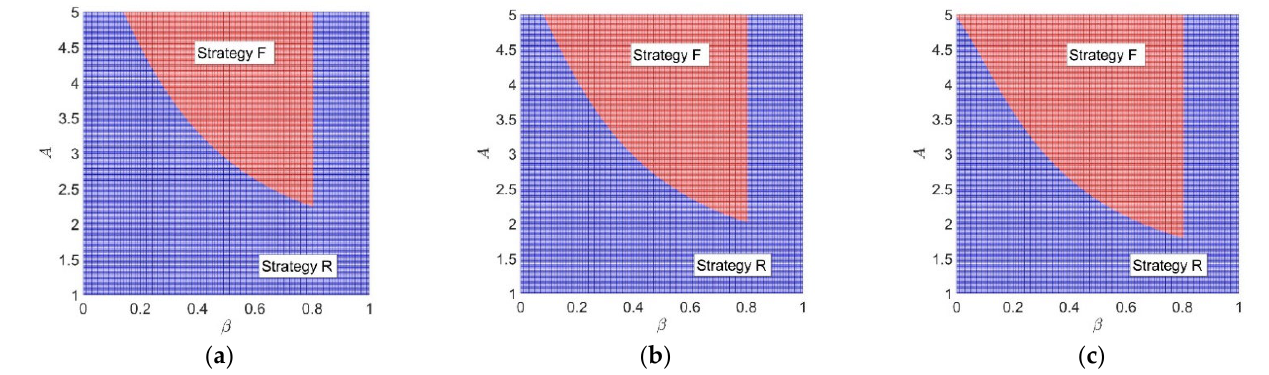
on the decision region when 𝑡𝑡